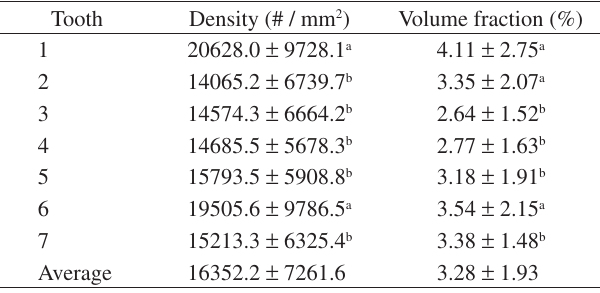
Figure 1. Typical image of dentin at the occlusal surface after digital process- ing. Table 1. Average value and standard deviation of the field and region pa- rameters analyzed. Values statistically different are referred to with different superscript letters for each of the parameters analyzed.